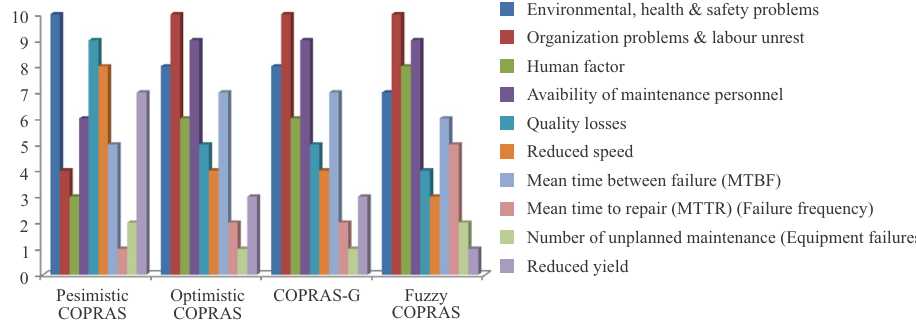
Fig. 6. The comparison of proposed Fuzzy COPRAS and other COPRAS